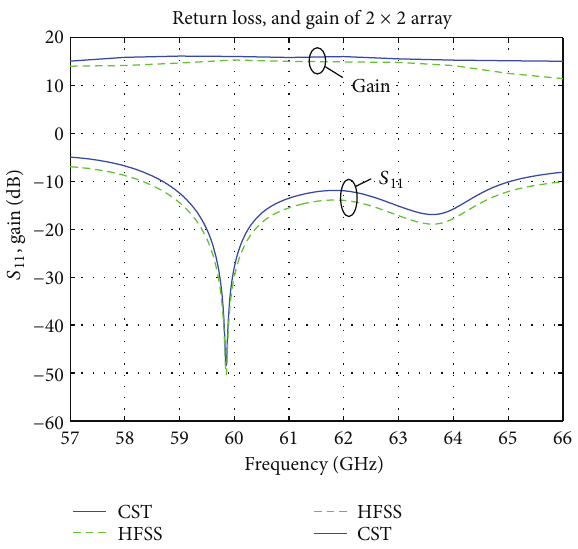
Figure 6: Return loss and gain of 2 × 2 array.